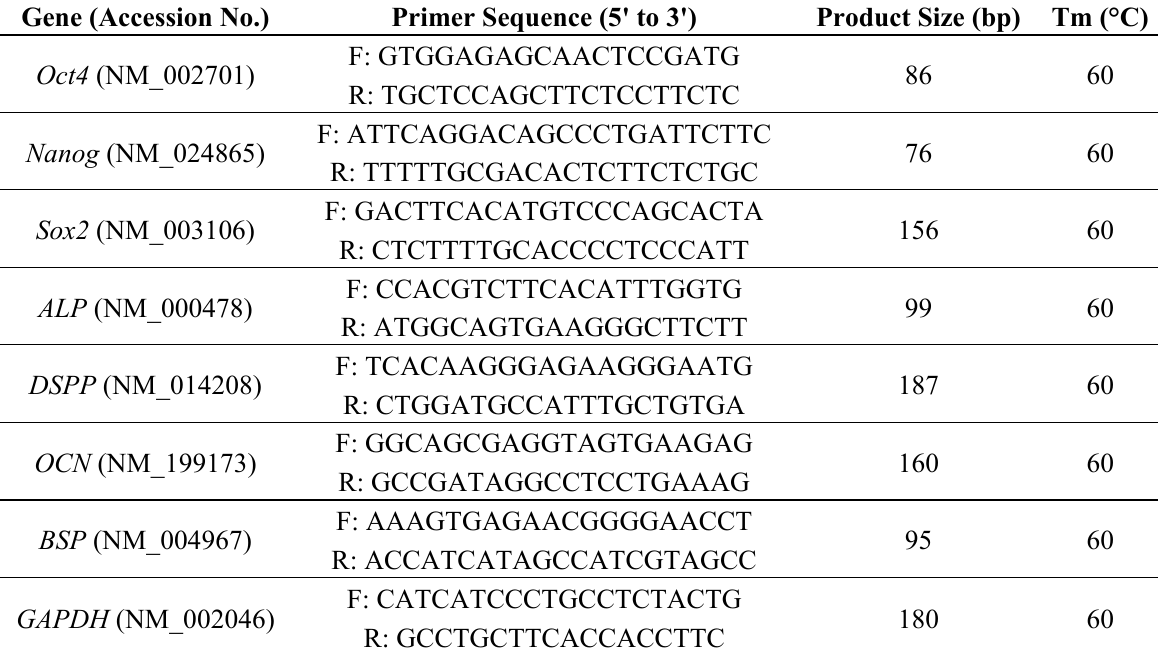
Table 1. The sequences of the primers for quantitative